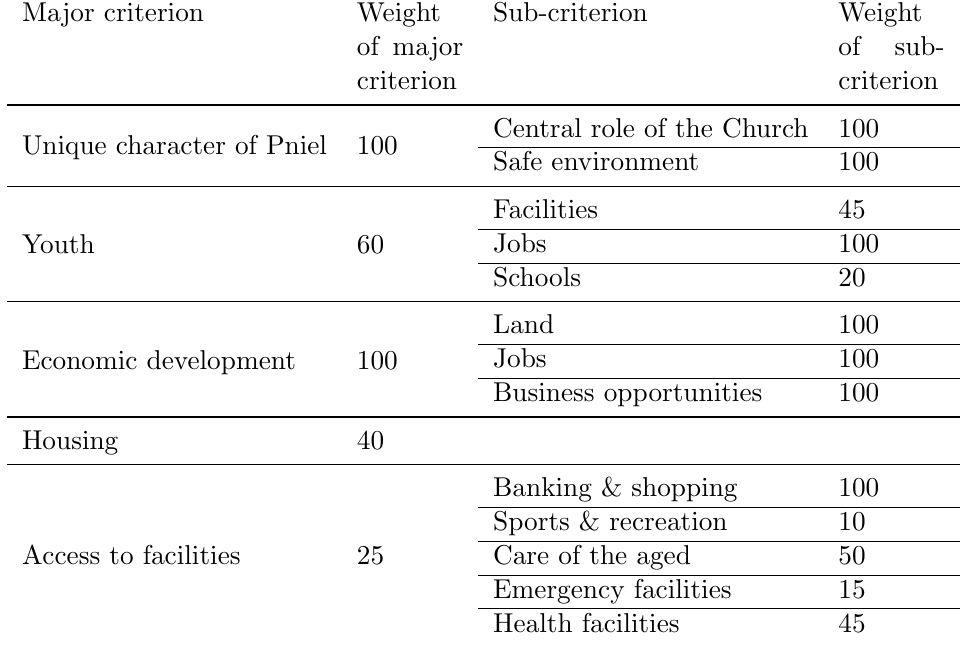
Table 1: Levels of importance of identified budget criteria in